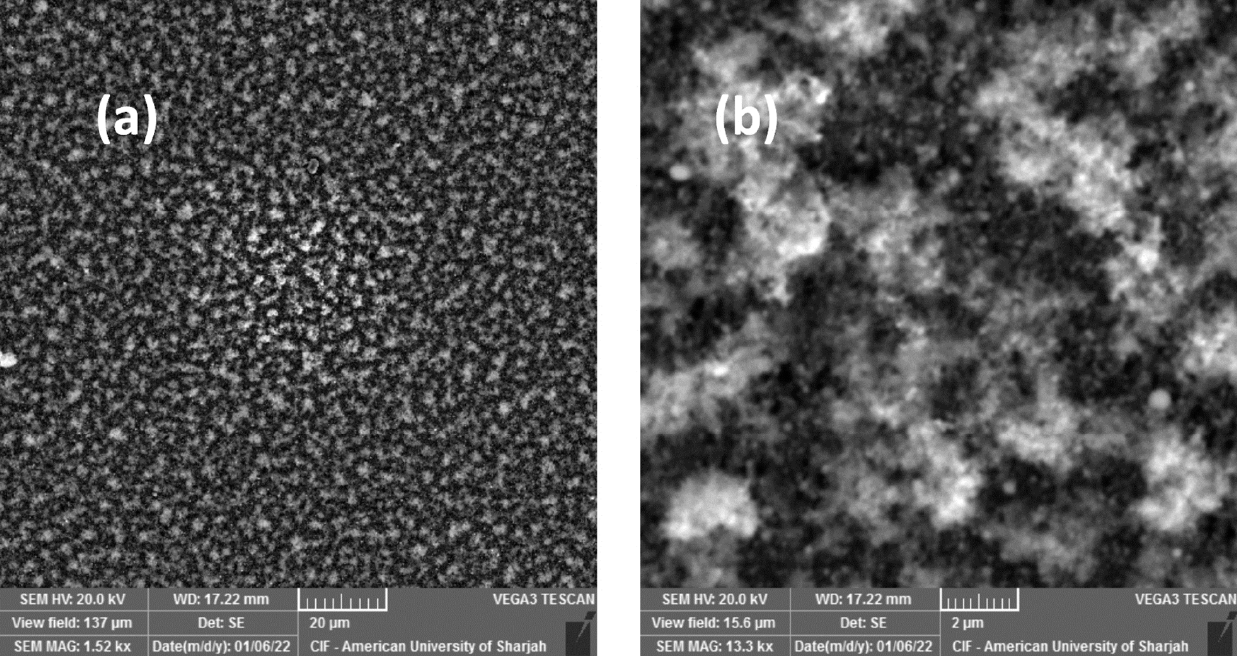
Figure 2. SEM micrographs of the as-deposited Mo thin film over mild steel (Mo/MS) at view fields of ( a ) 137 μm and ( b ) 15.6 μm